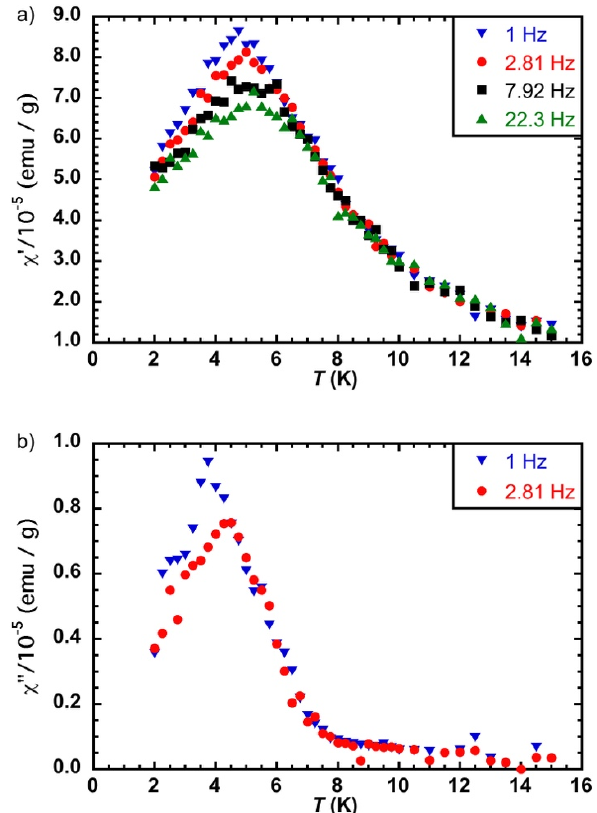
Figure 6. ( a ) χ ’ = f( T ) and ( b ) χ ” = f( T ) at different frequencies of the alternating magnetic field (3 Oe) for CsCoFe_PVP; laser power 65 mW/cm 2 .